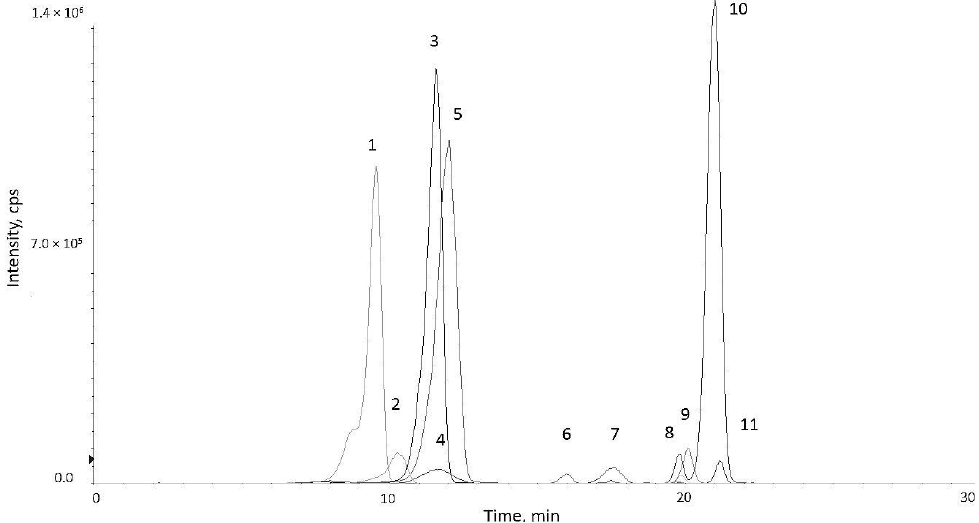
Figure 3. UPLC-ESI-MS/MS extracted ion chromatograms (XICs) in positive-ion mode for GPE_10pDG2p. The numbering of the peaks is by the retention time. Peak assignment is reported in Table 2.